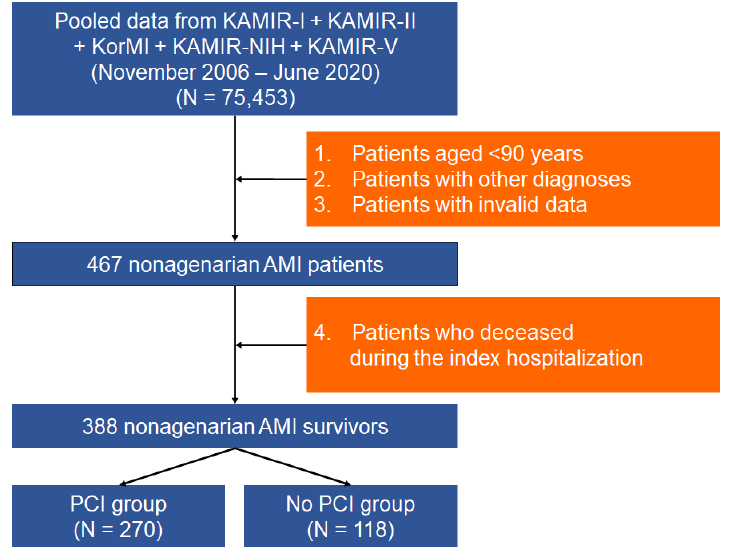
Figure 1. Diagram of the study design. AMI, acute myocardial infarction; KAMIR, Korean Acute Myocardial Infarction Registry; KAMIR-NIH, Korean Acute Myocardial Infarction Registry-National Institute of Health; KorMI, Korea Working Group on Myocardial Infarction; PCI, percutaneous coronary intervention.